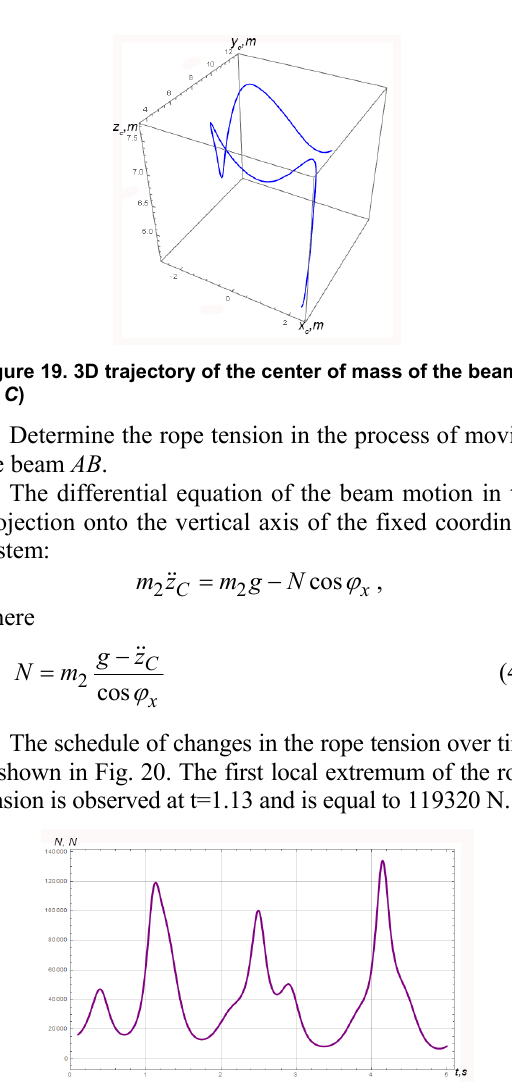
Figure 20. Graph of changing the rope tension over time The position of the beam AB for the moment is